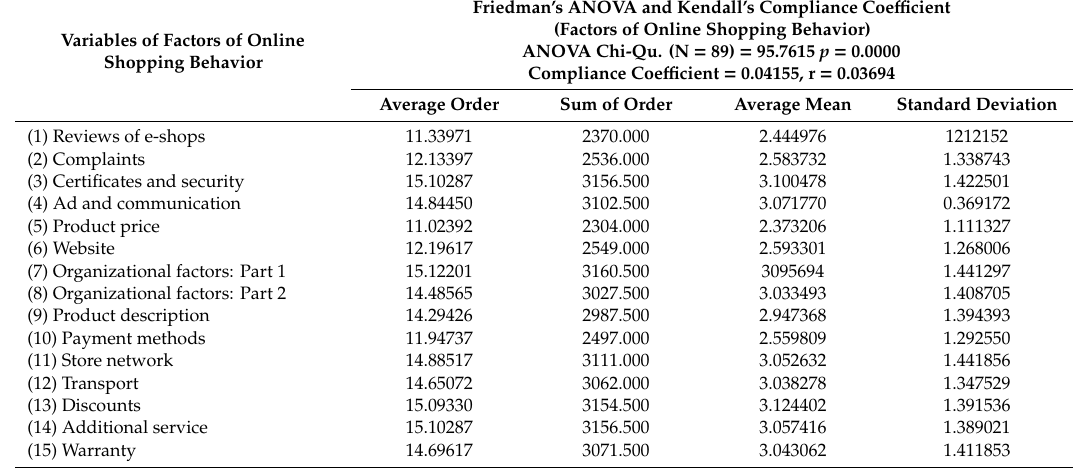
Table 6. Friedman’s ANOVA and Kendall’s compliance coe ffi cient: Factors of online shopping behavior (source: own processing in the Statistica